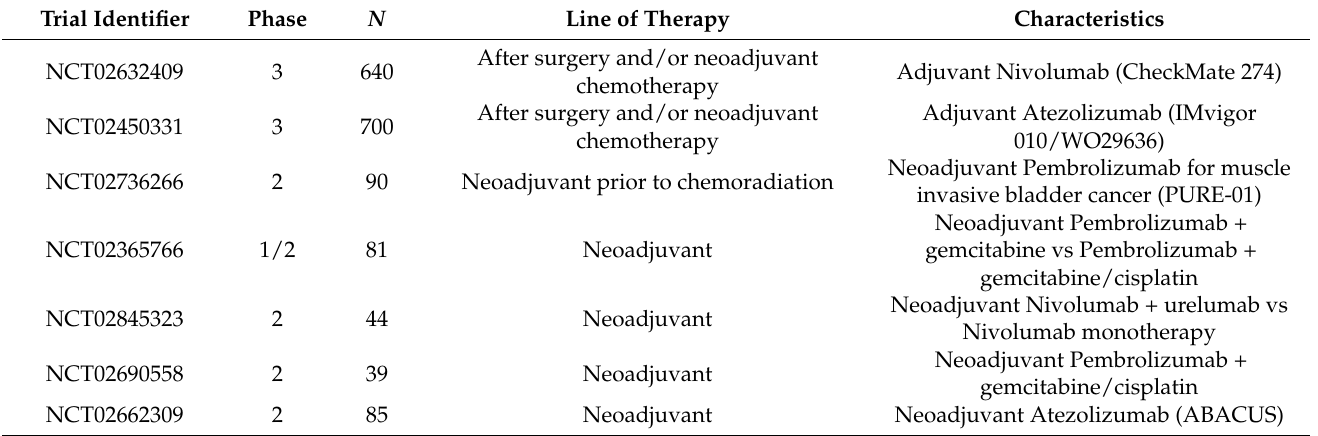
Table 2. Adjuvant and neoadjuvant immunotherapy trials in bladder